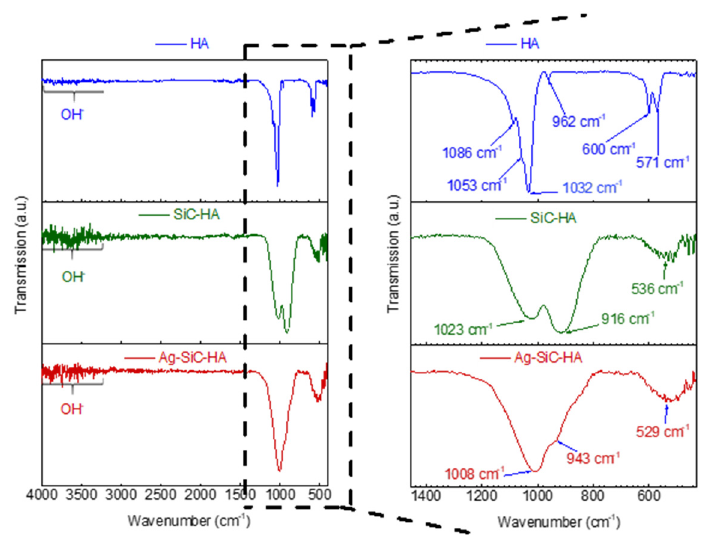
Figure 5. FTIR spectra of HAP-based